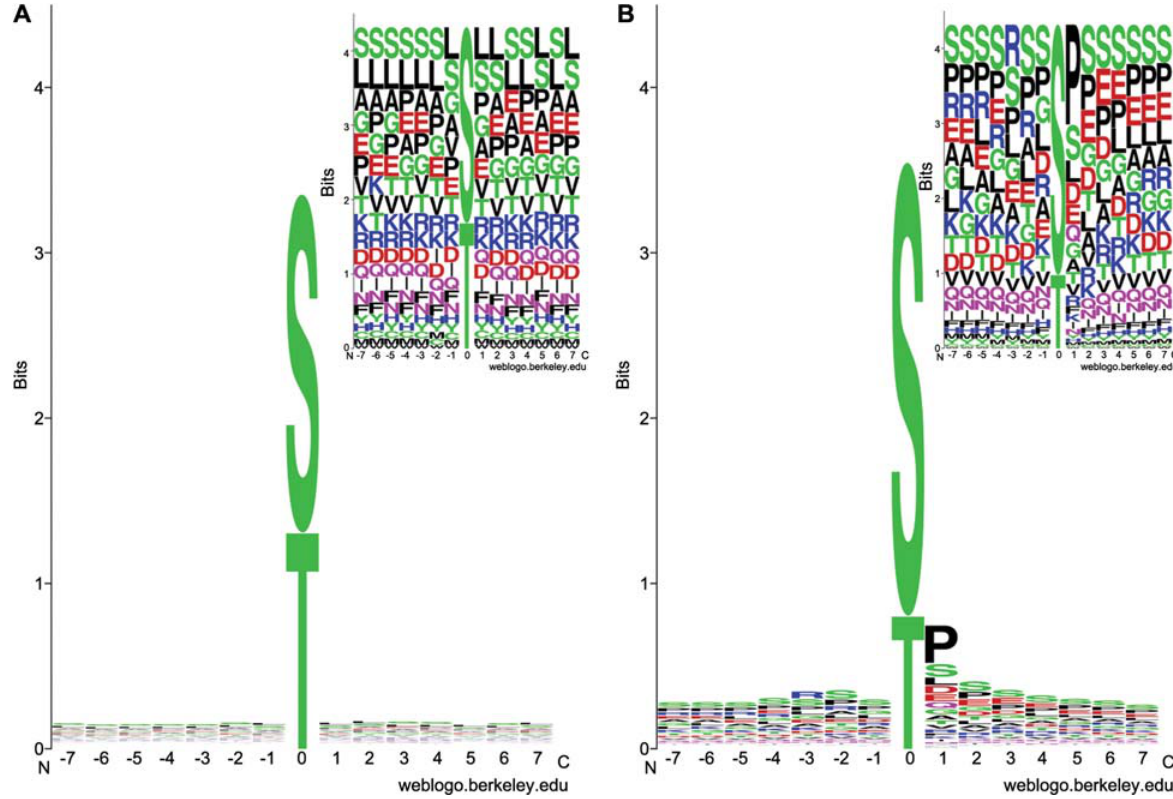
Figure 1 Weblogo analysis of Ser/Thr proteome and phosphoproteome. (A) Weblogo representation of 35679 random peptides centered on Ser or Thr residues collected as described in the Methods section. In the inset the corresponding frequency plot is reported. (B) Weblogo representation of 35679 phospho-Ser/Thr peptides from Phospho- SitePlus (cid:2) . In the inset the corresponding frequency plot is